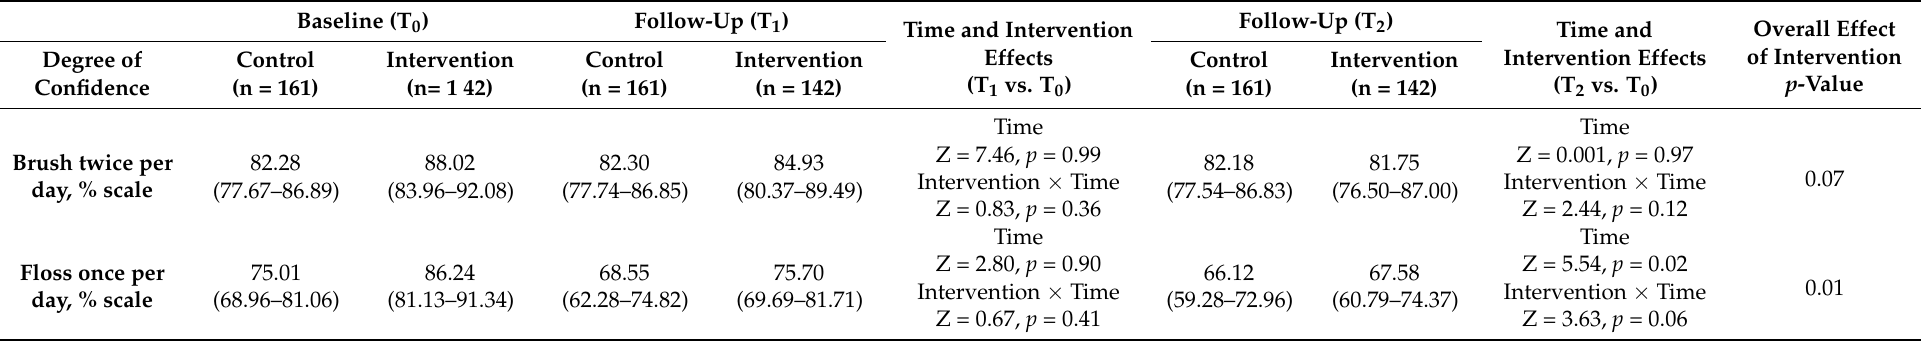
Table 2. Estimated marginal means and 95% confidence interval (95% C.I.) for degree of confidence at being able to maintain tooth brushing and flossing for the two-study groups at the baseline and the two follow up visits.